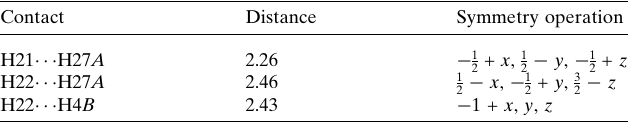
Table 2 Short H (cid:2)(cid:2)(cid:2) H interatomic contacts (A˚ ) in the title compound. Contact